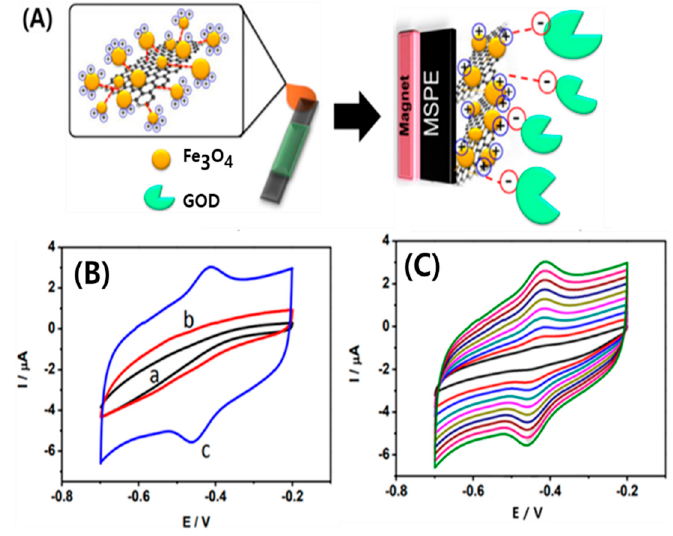
Figure 10. Self-assembly of glucose oxidase (GOD) on rGO-magnetic nanoparticles nanocomposite-based direct electrochemistry for reagentless glucose biosensor. ( A ) Schematic illustration of rGO-Fe 3 O 4 / GOD modified MSPE. ( B ) Cyclic voltammograms of the di ff erent modified electrodes with (a) GOD / MSPE, (b) Fe 3 O 4 / GOD / MSPE, and (c) rGO-Fe 3 O 4 / GOD / MSPE, in 0.1 M PBS at pH 7.0 with N 2 -saturated at